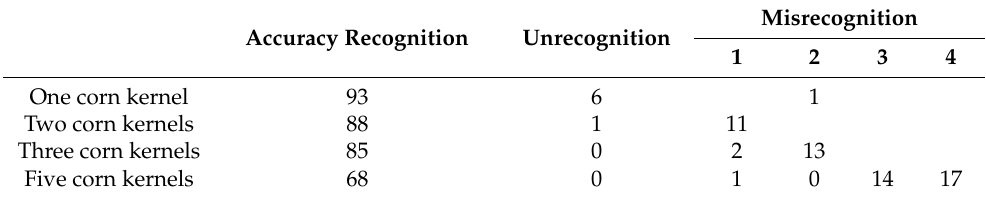
Table 2. Recognition accuracy